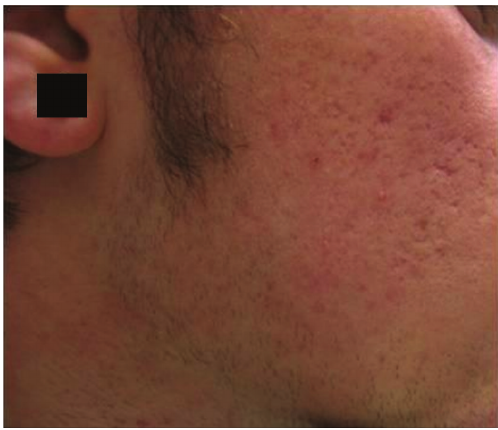
Figure 7: Needling: patient before the treatment.